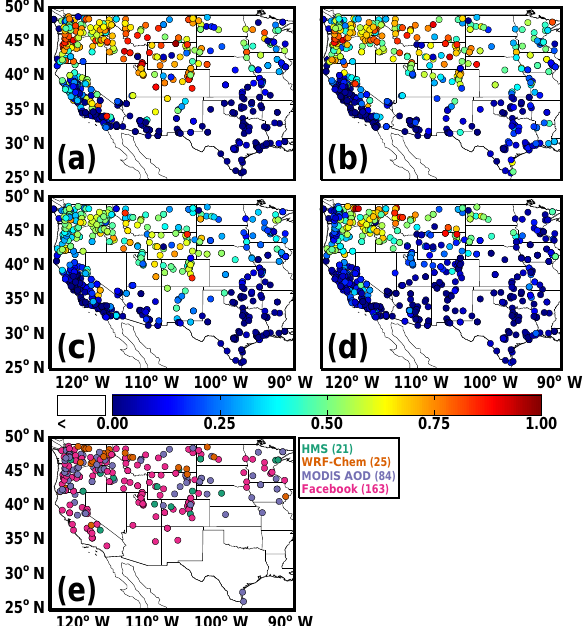
Figure 4. R 2 values for surface measurements of PM 2 . 5 with (a) percent of Facebook posters (CF<0.75), (b) MODIS AOD (CF<0.75), (c) HMS smoke, and (d) WRF-Chem-simulated PM 2 . 5 for the period of 5 June to 30 September 2015. (e) Product (HMS Smoke, WRF-Chem PM 2 . 5 , MODIS AOD, or Facebook posters) that has the highest R 2 compared to surface measurements for the time period of 5 June to 30 September 2015 (sites are shown only if the resulting R 2 >0.5). The number of sites in the western US (do- main shown) where the product has the highest R 2 (and R 2 >0.5) is given in